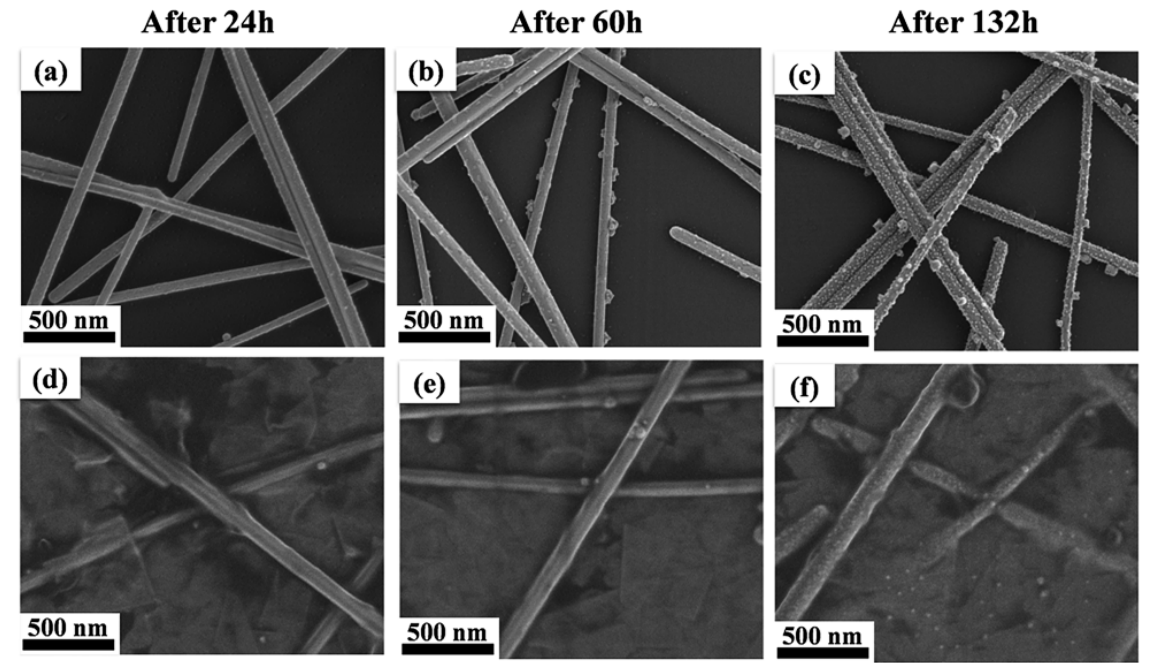
Figure 16. ( a ) Cyclic bending test results of silver nanowire networks with and without RGO coating after exposing them at 70 °C for 132 h. ( b ) Sheet resistance change of silver nanowire networks with and without RGO coating as a function of exposure time in air at 70 °C. Resistance change of bare silver nanowire networks with GO and RGO coatings exposed to air ( c ) at 120°C and ( d ) at 85 °C with 85% relative humidity. Reproduced with permission from ref. [49] with permission from The Royal Society of Chemistry. Reproduced with permission from ref. [50]. Copyright 2018, Elsevier.